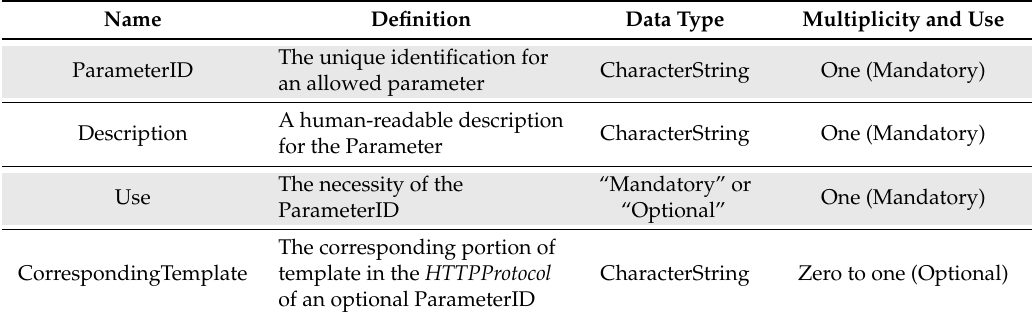
Table 3. Properties of the Parameter .